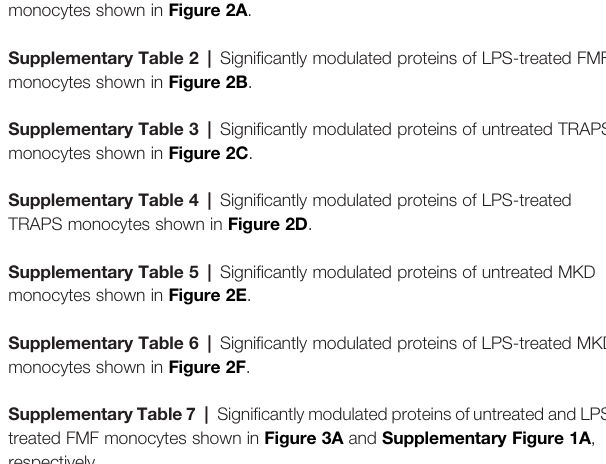
Supplementary Table 4 | Signi fi cantly modulated proteins of LPS-treated TRAPS monocytes shown in Figure 2D . Supplementary Table 5 | Signi fi cantly modulated proteins of untreated MKD monocytes shown in Figure 2E . Supplementary Table 6 | Signi fi cantly modulated proteins of LPS-treated MKD monocytes shown in Figure 2F . Supplementary Table 7 | Signi fi cantly modulated proteins of untreated and LPS- treated FMF monocytes shown in Figure 3A and Supplementary Figure 1A , respectively. Supplementary Table 8 | Signi fi cantly modulated proteins of untreated and LPS- treated TRAPS monocytes shown in Figure 3B and Supplementary Figure 1B , respectively. Supplementary Table 9 | Signi fi cantly modulated proteins of untreated and LPS- treated MKD monocytes shown in Figure 3C and Supplementary Figure 1C ,